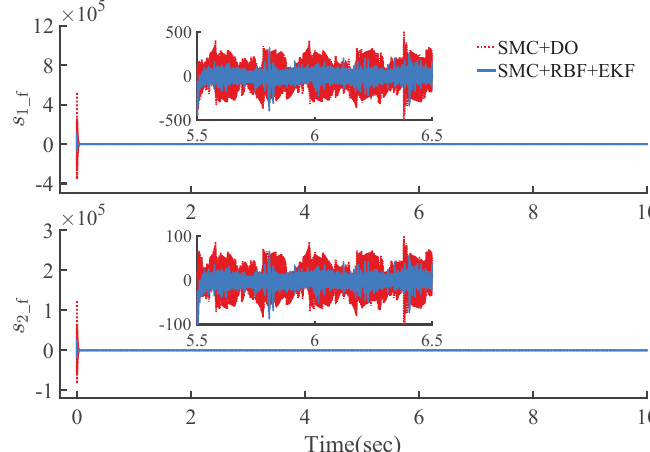
Figure 14. Time history of the fast sliding surface s _f .